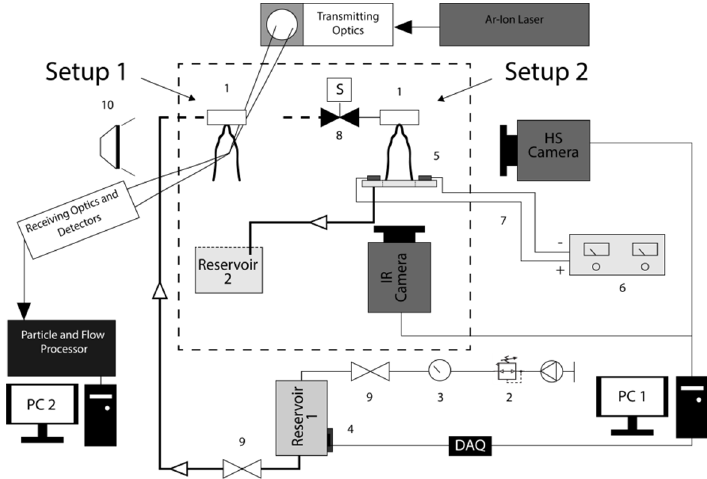
Figure 1. Schematic of the experimental apparatus. (1) Atomizer, (2) air pressure regulator, (3) manometer, (4) temperature sensor, (5) impact surface, (6) power supply, (7) electric cables, (8) solenoid valve, (9) manual valve, (10) light source.